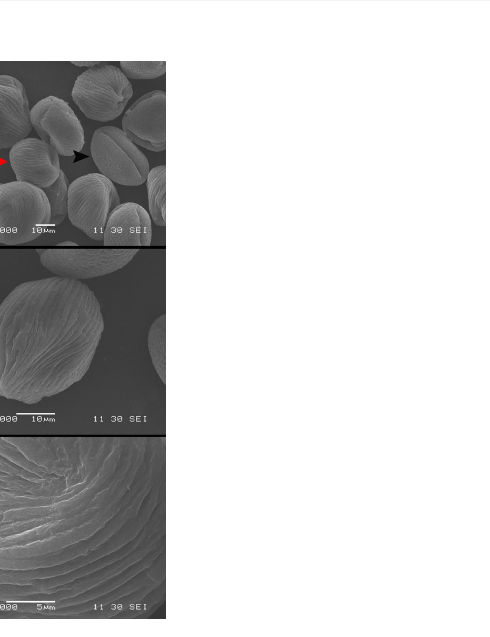
FIGURE 2 Comparison of morphological characteristics of pollen and pseudopollen of Camellia oleifera under SEM. (A, B) Morphological differences between normal pollen grains and pseudopollen grains. The black arrow indicates normal pollen; the red arrow indicates pseudopollen. 2 (C) Complete morphology of normal pollen grains. The black arrow indicates a pollen aperture (D) Complete morphology of pseudopollen grains (E) Grid ornamentation of the exine of normal pollen (F) Parallel ribs in the wall of pseudopollen